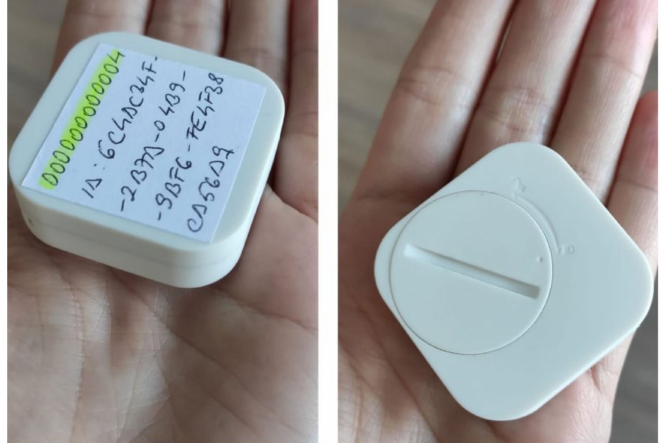
Figure 4. iB004N beacons used for beacon-based